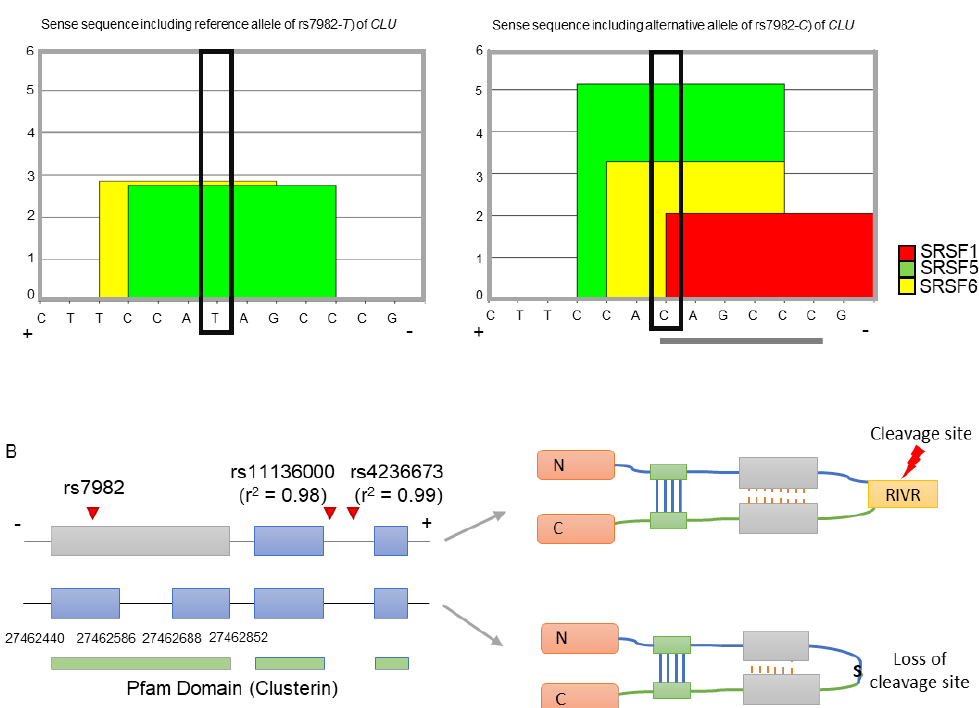
Figure 1. Splicing modulation and functional impact of rs7982. ( A ) The reference allele (T) is involved in two binding motif, SRSF5 and SRSF6 (left figure), while the alternative allele (C) is involved in three motifs, SRSF1, SRSF5, and SRSF6 (right figure). Gray lines underneath indicate each hexameric exonic splicing enhancer (ESE) sequence. The black box indicates allele rs7982 in the binding motif. ( B ) The SNP is located in the 5th exon of CLU. Isoforms retaining the intron (upper transcript) are translated into normally functioning proteins containing the RIVR (Arg-Ile-Val-Arg) sequence, which is part of a key cleavage site; isoforms without the retained intron (lower transcript) produce dysfunctional proteins lacking the cleavage site. The + and – refers a DNA strand as a template. N and C is the N-terminal and C-terminal domain respectively. S indicates serine amino acid.